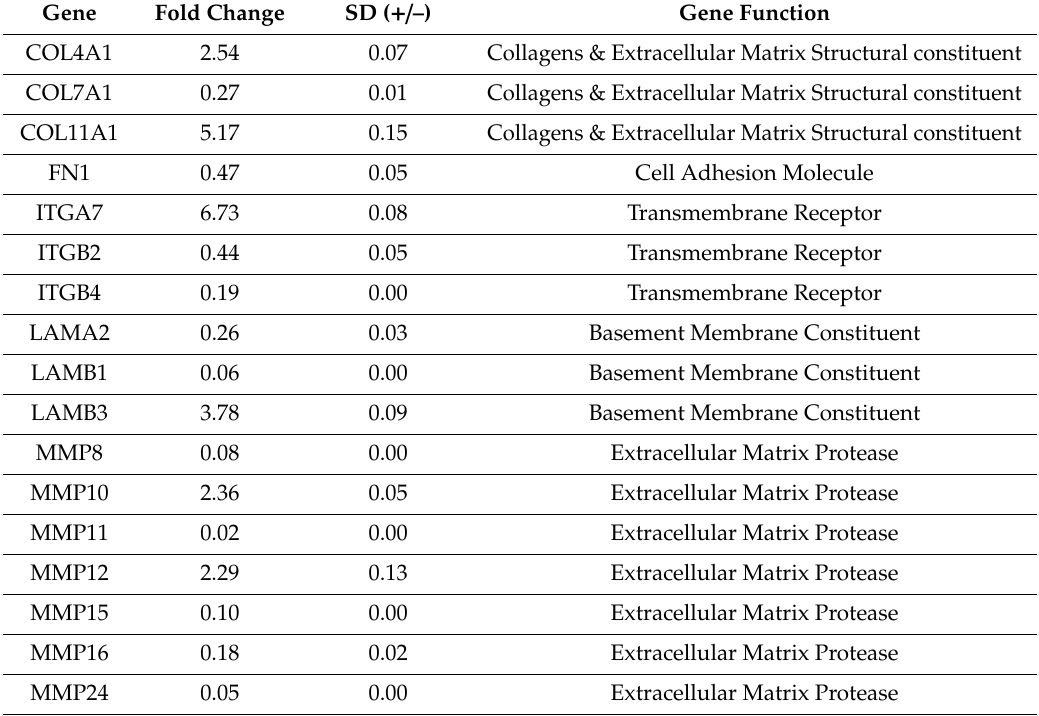
Table 3. Significant gene expression levels after 24 h of treatment with diphenylhydantoin compared with the untreated